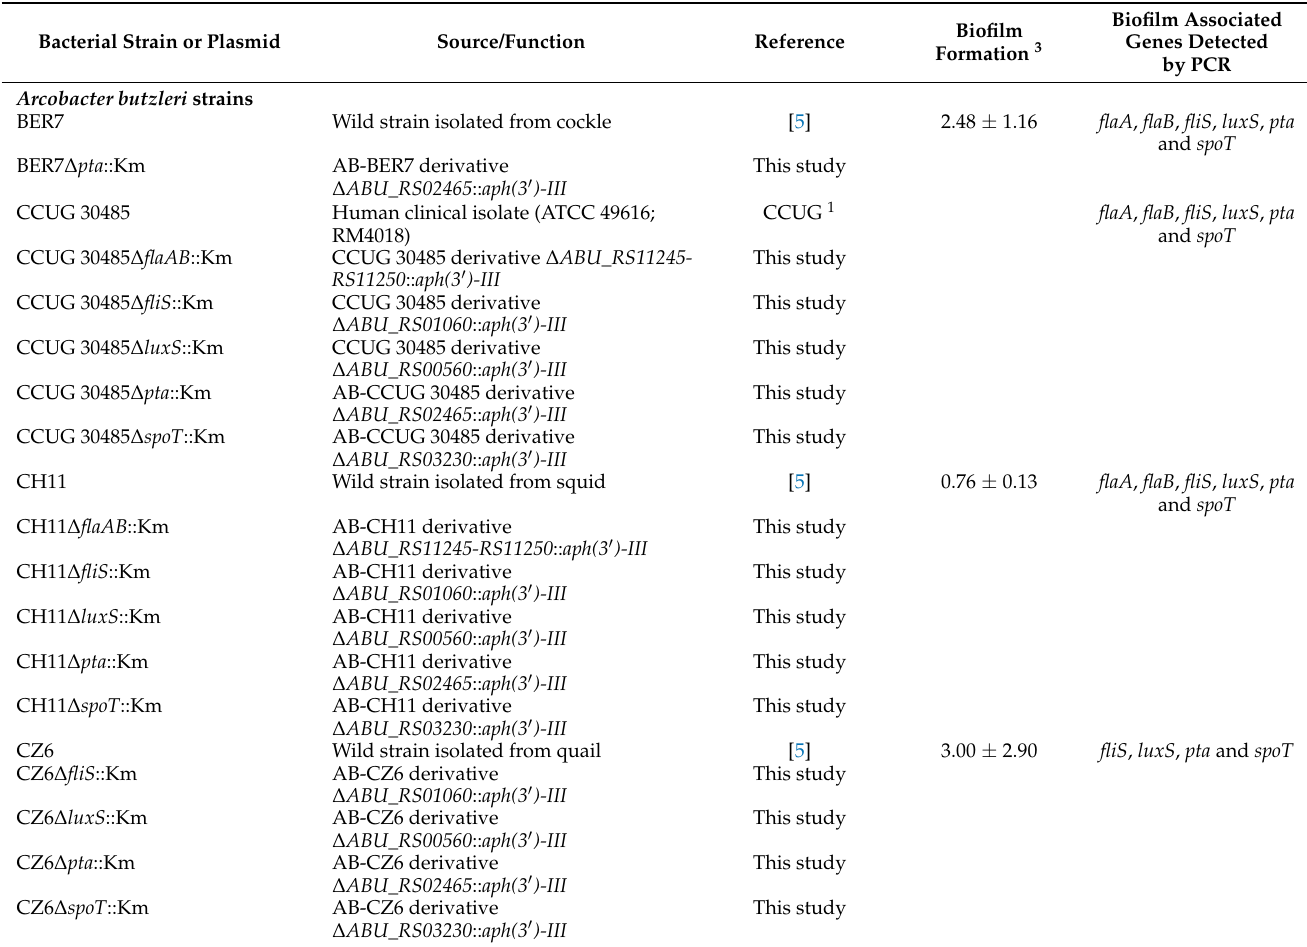
Table 1. Bacterial strains and plasmids used in this